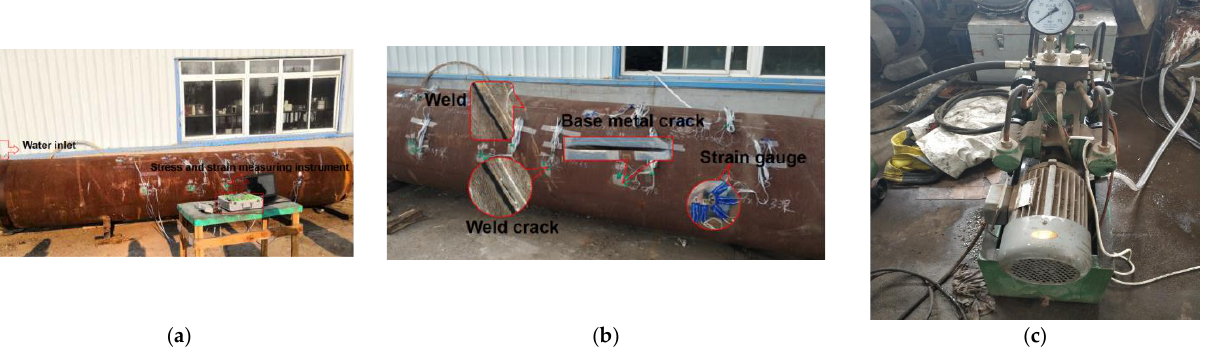
( d ) Figure 23. Variations of Kmax and S(K) parameters at 3 MPa. ( a ) Axial component of Kmax ; ( b ) radial component of Kmax . ( c ) Axial component of S ( k ); ( d ) radial component of S ( k ). It can be observed from the above-illustrated figure that during weld crack detection, Kmax and S ( K ) significantly changed, the stress concentration was large, and the risk of failure was high. Therefore, the pipe weld crack should be detected in time with this method. 4. Experiment and Analysis In order to study the weak magnetic signal characteristics of weld cracks in long oil and gas pipelines and verify the reliability of the numerical model, a pipeline pressuriza- tion experiment was designed to analyze the changes of the weak magnetic signal charac- teristic parameters of pipeline welds, weld cracks, and base metal cracks. The experi-